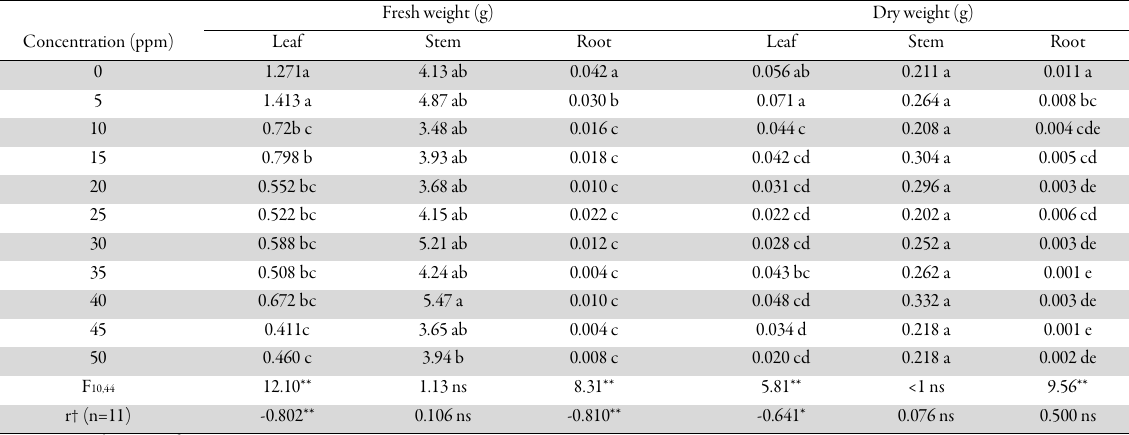
Table 3. Fresh and dry weight of leaves, stem and roots of Talinum portulacifolium exposed to different concentrations of Zinc after 35 days of growth Concentration